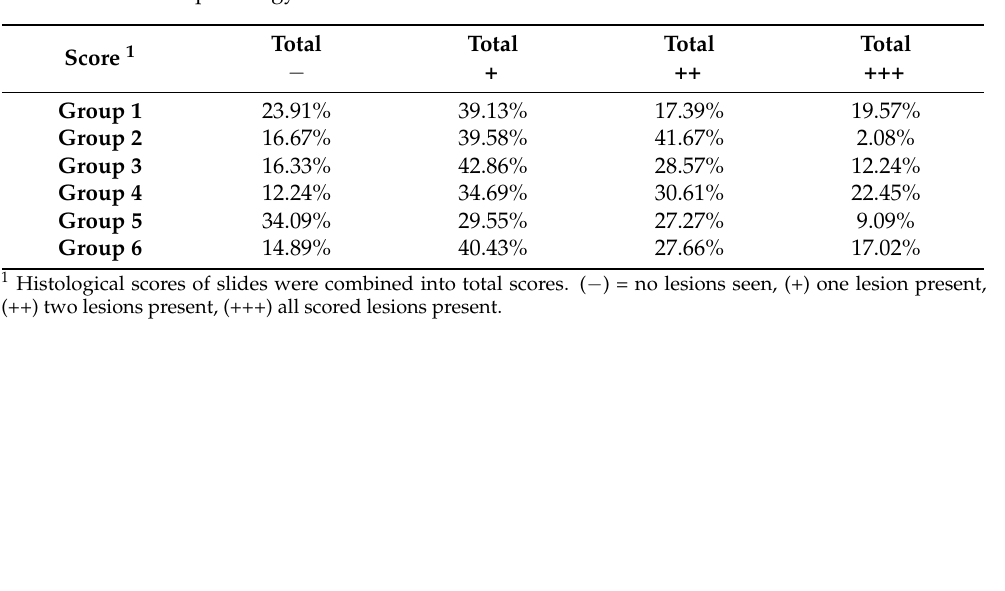
Figure 3. Representative histological findings from M41 challenge: ( A ) exudate in the lumen of the oviduct (arrow) of a 13-week-old bird challenged with M41 at 7 DOA; ( B ) lymphoid nodules (arrow) in the oviduct of a 19-week-old bird challenged with DMV at 3 DOA; ( C ) dilated oviduct with flattened mucosa (arrow) from a 5-week-old bird challenged with M41 at 7 DOA. Table 5. Total Histopathology